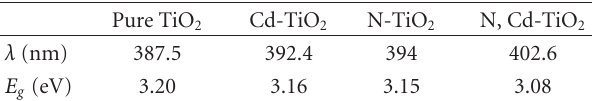
Table 1: Absorption edges and the band gaps of